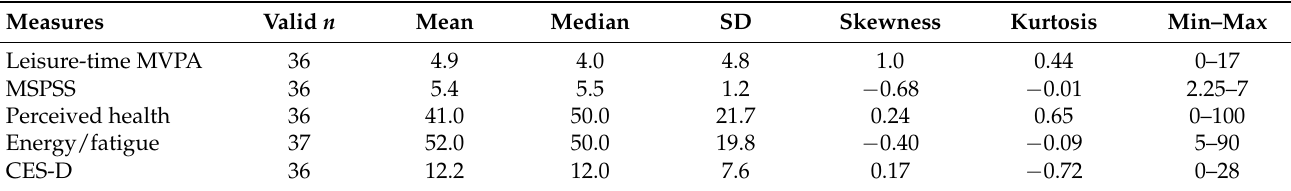
Table 3. Caregivers’ physical activity, perceived social support, and standardized outcome measures and distributions.